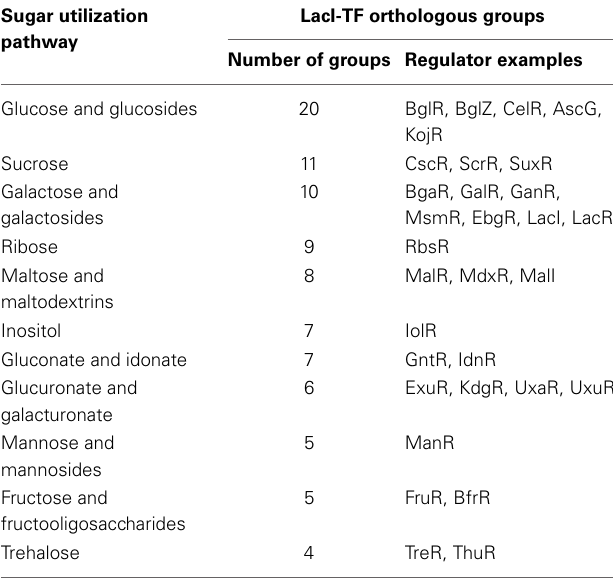
Table 1 | Sugar utilization pathways controlled by non-orthologous